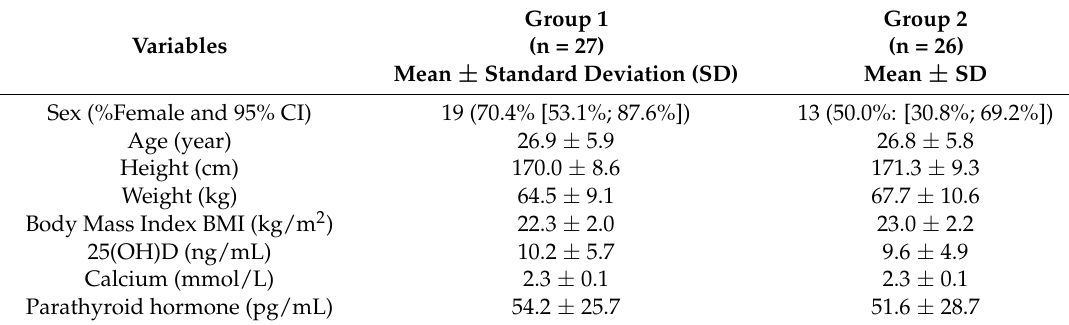
Table 1. Characteristics of